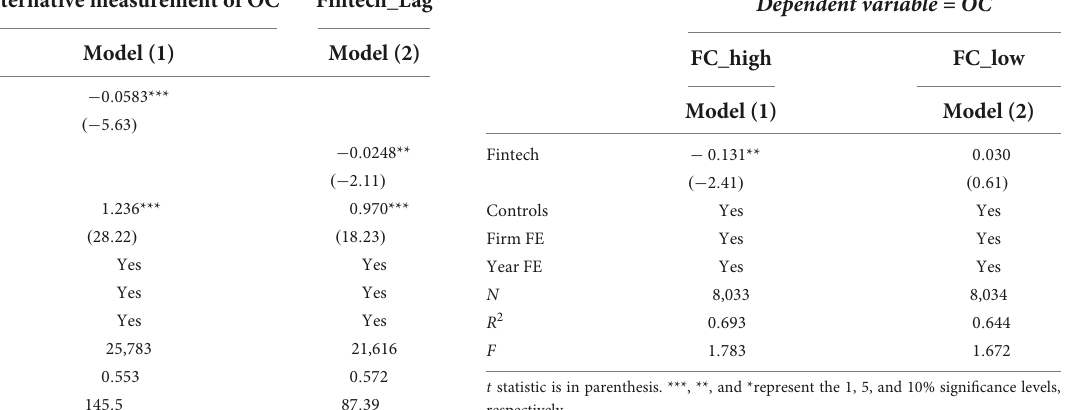
TABLE 8 Test the effect of financing constraints.